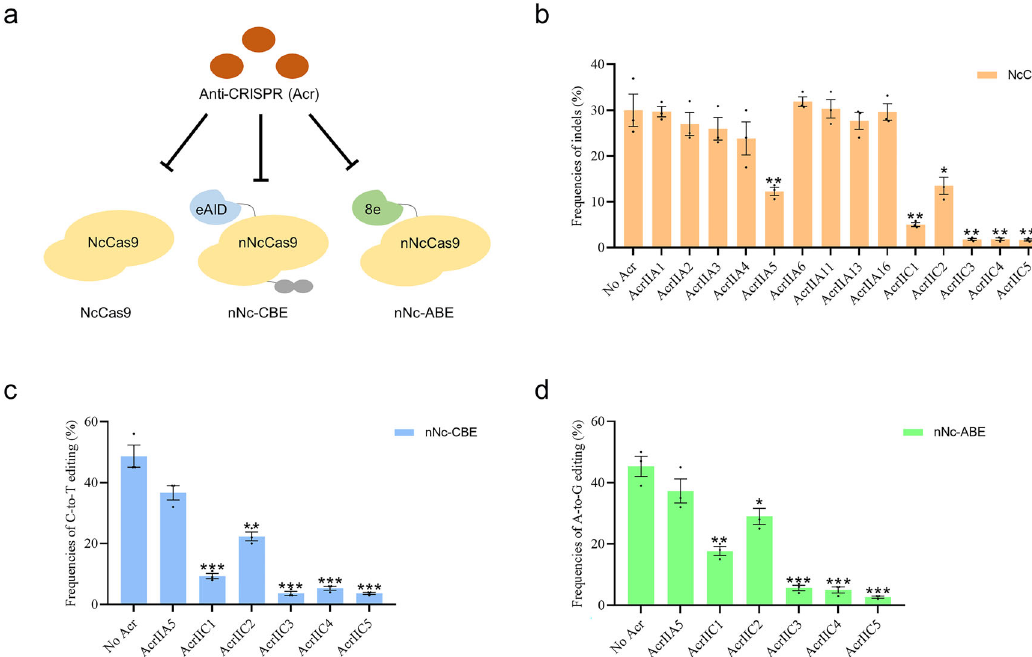
Fig. 4 NcCas9 is inhibited by Acr proteins in human cells. a Schematic of Acr proteins is used to inhibit the activities of NcCas9 and its base editors. b Genome editing of NcCas9 in the presence or absence of the 14 previously described Acr families. Plasmids expressing NcCas9, sgRNA targeting site5, and each Acr (1:1:1) were co-transfected into HEK293T cells. c Base editing of nNc-CBE in the presence or absence of six Acrs at the site1. d Base editing of nNc-ABE in the presence or absence of six Acrs at site1. Error bars indicate the s.e.m. ( n = 3). Table 1 Generation of targeted editing in mouse embryos by